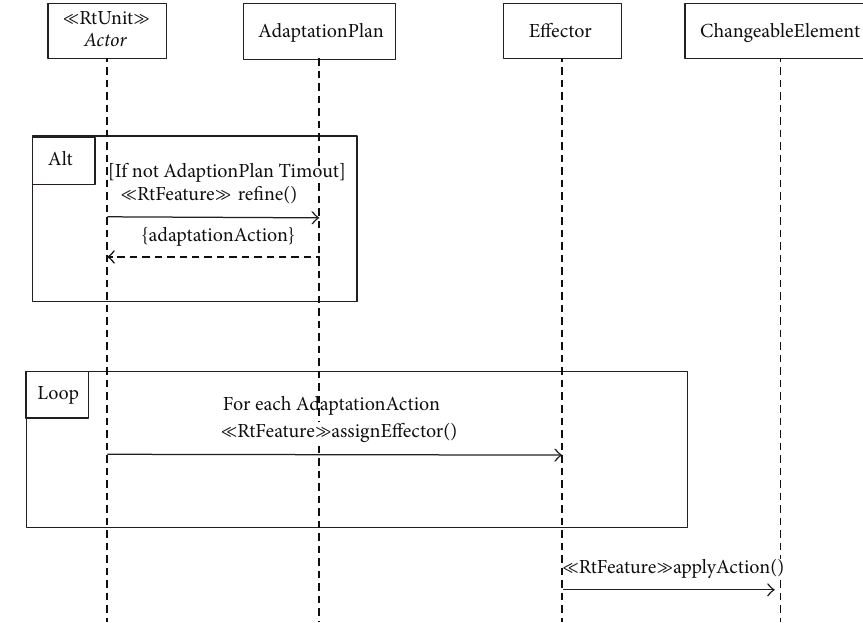
Figure 10: Behavioral view of the RTE Actor pattern.